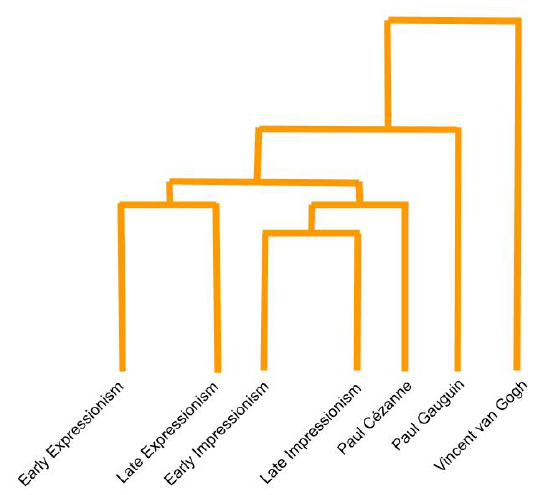
Figure 1. Clustering of art styles based on art historical